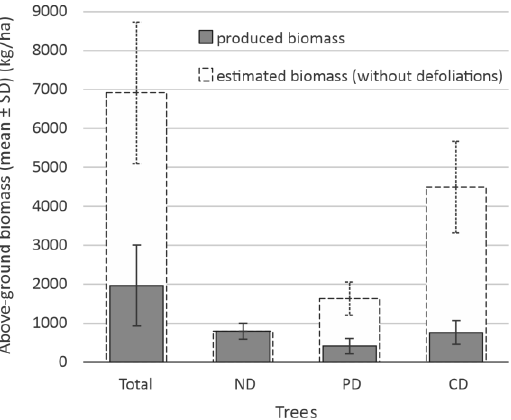
Figure 8. The aboveground biomass per hectare in 2017 and the estimated aboveground biomass in the absence of defoliation. ND — non-defoliated trees; PD — partially defoliated trees; CD — com- the absence of defoliation. ND—non-defoliated trees; PD—partially defoliated trees; CD—completely pletely defoliated trees. defoliated